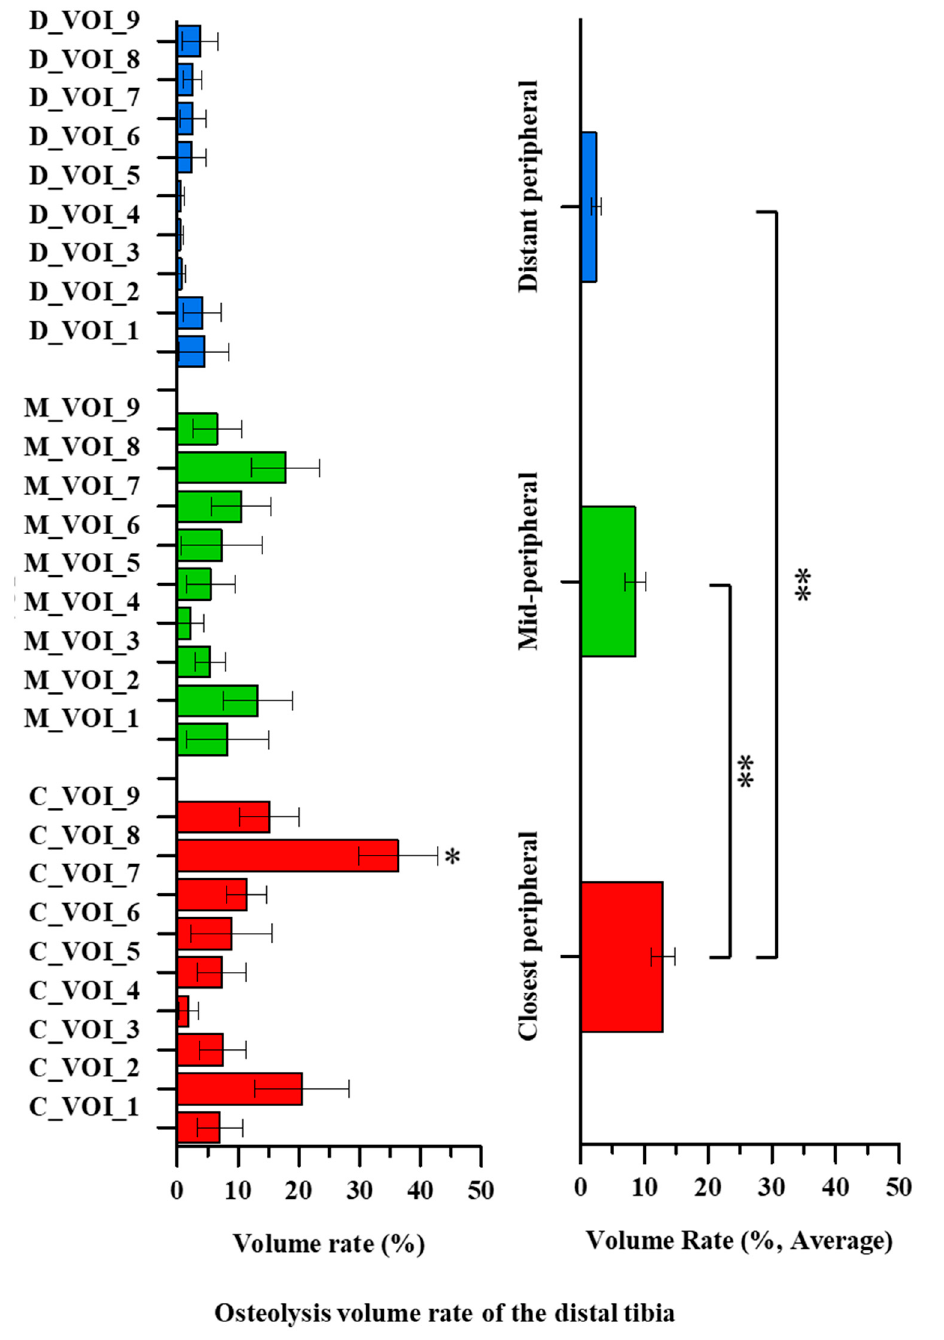
Figure 4. The average distal tibial osteolysis volume of 12 patients. Significant differences are indicated by double asterisks (one-way ANOVA followed by Fisher’s LSD test, p < 0.05). Single asterisks indicate a significant difference compared to the center region (C_VOI_5, M_VOI_5 or D_VOI_5) ( p < 0.05).